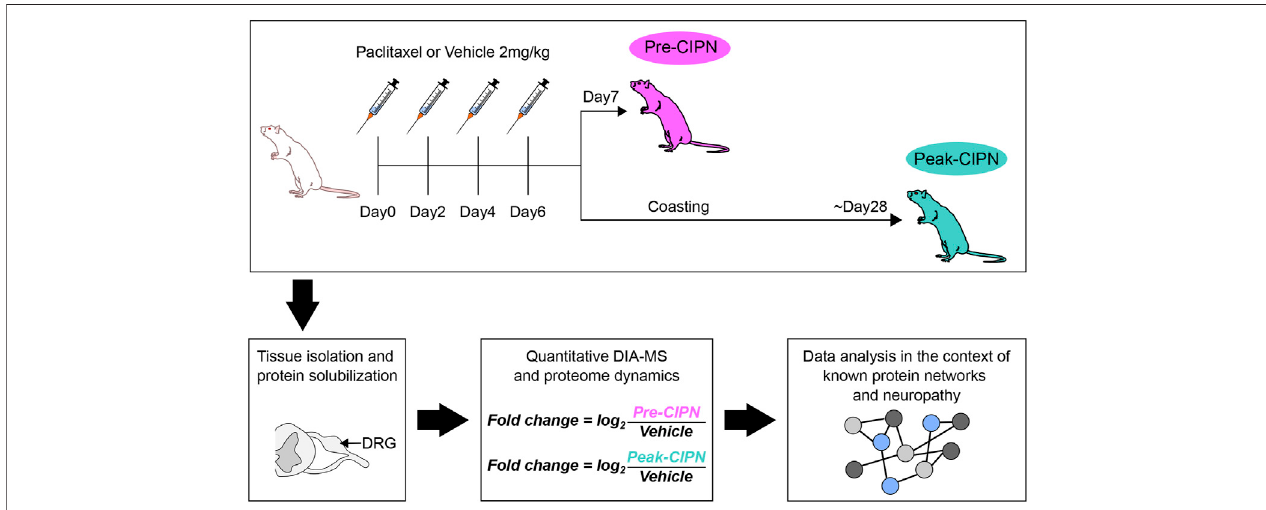
FIGURE 1 | Schematic overview of the integrated work fl ow: from paclitaxel or vehicle administration via behavioural assessment of neuropathy, protein solubilization, and quantitative DIA-MS to analysis of altered protein networks.